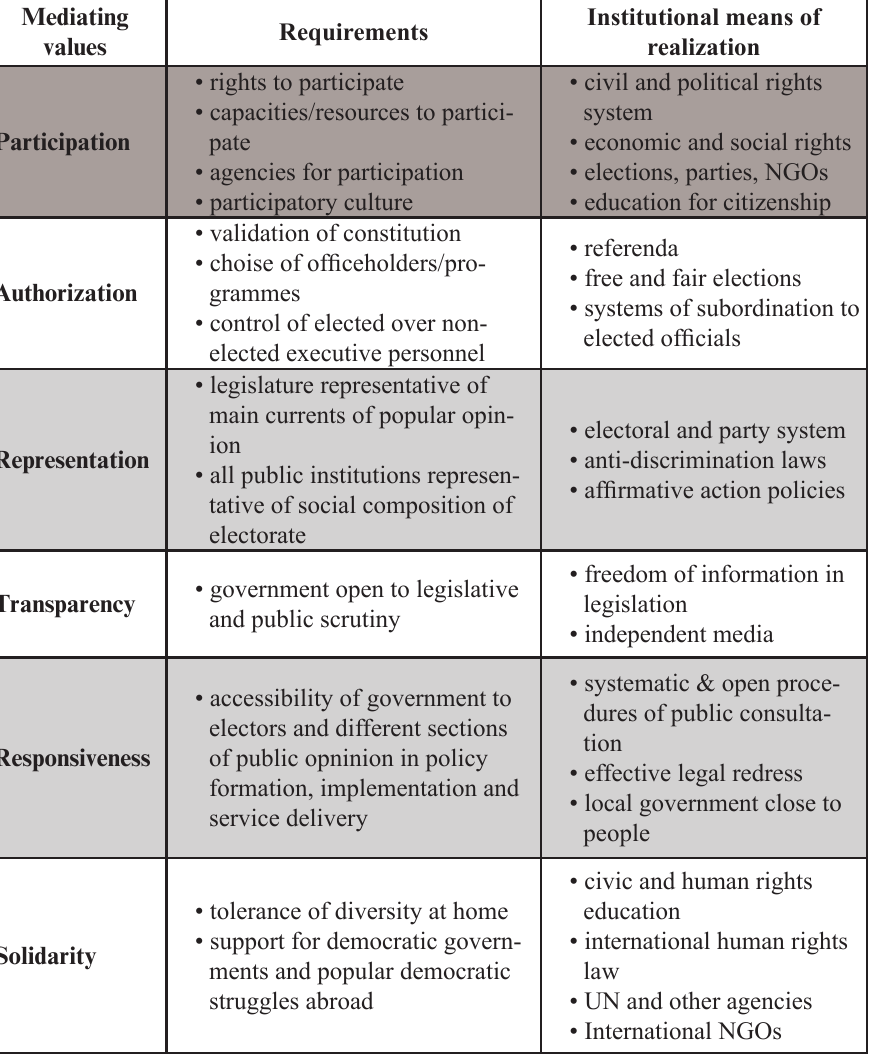
Table 1. Mediating values, requirements, and institutional means